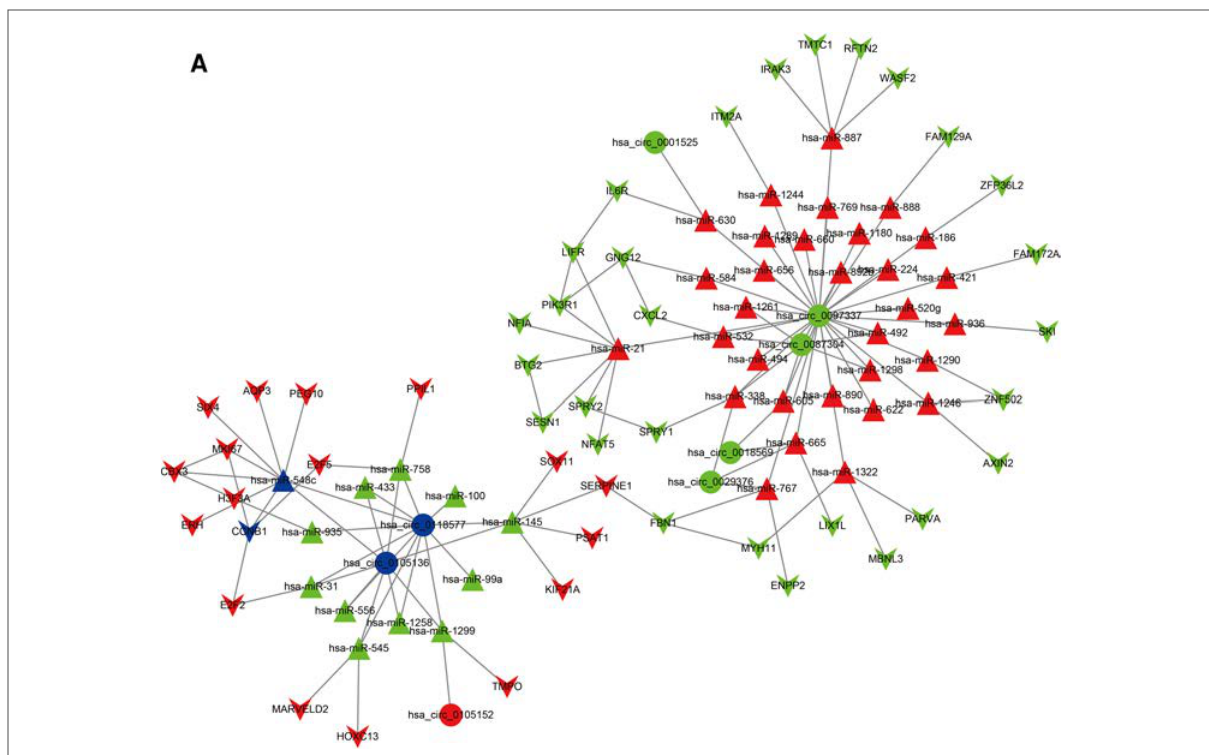
FIGURE 4 The ceRNA network of circRNA-miRNA-mRNA in BC. Circles represent circRNAs, triangles indicate miRNAs, and “ V ” indicates mRNAs. The red and green nodesindicate upregulation anddownregulation, respectively.Blue represents the hub